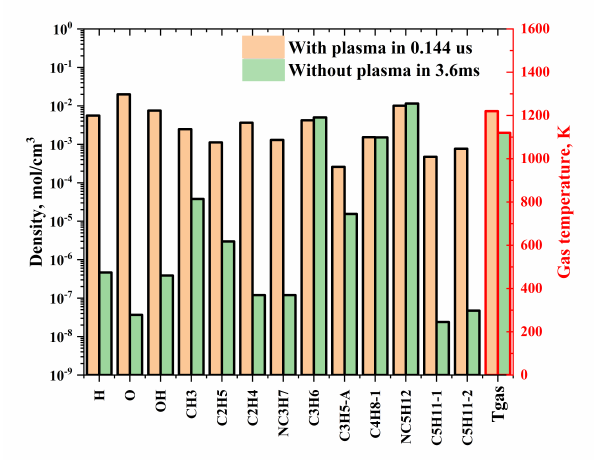
Figure 17. Species density and temperature comparison between combustion with plasma and that without plasma when pentane conversion is